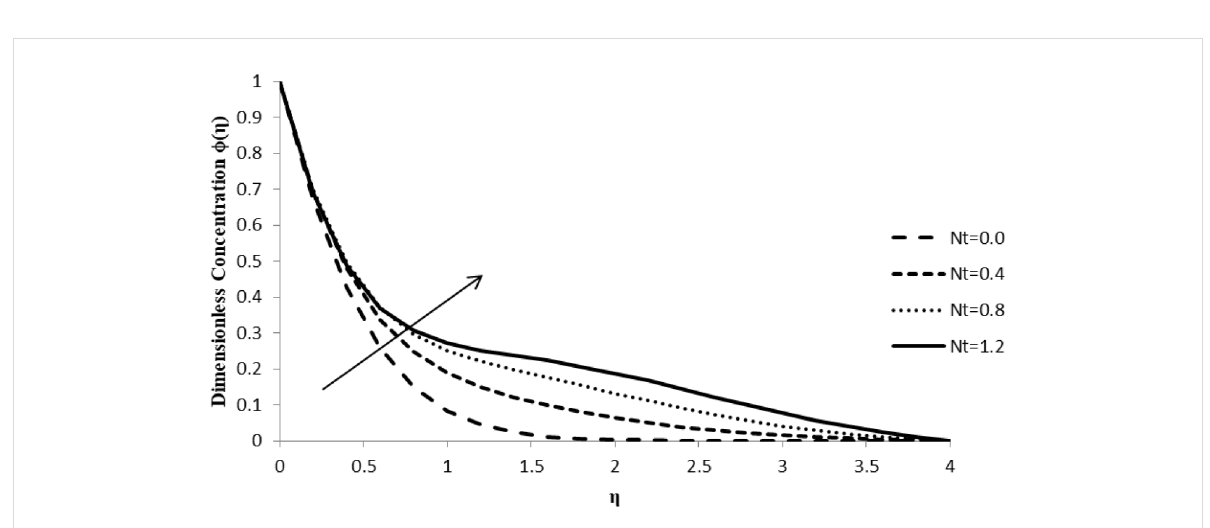
Figure 10: Influence of the thermophoresis parameter Nt on the temperature distribution θ ( η ) when n = 2.0, ξ = 1.0, M = Q = 0.0, Pr = 2.0, Nb = 0.5, Le = 5.0, and F w = 0.2.